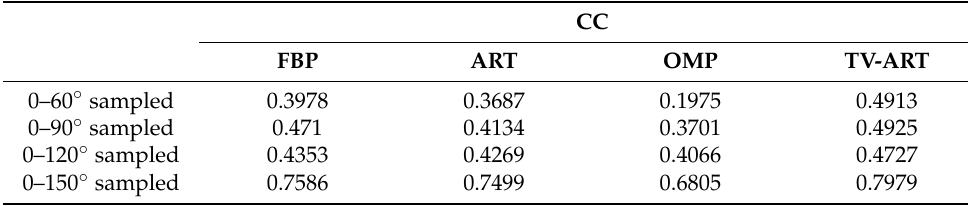
Table 6. CC values of different algorithms with incomplete views of projection.